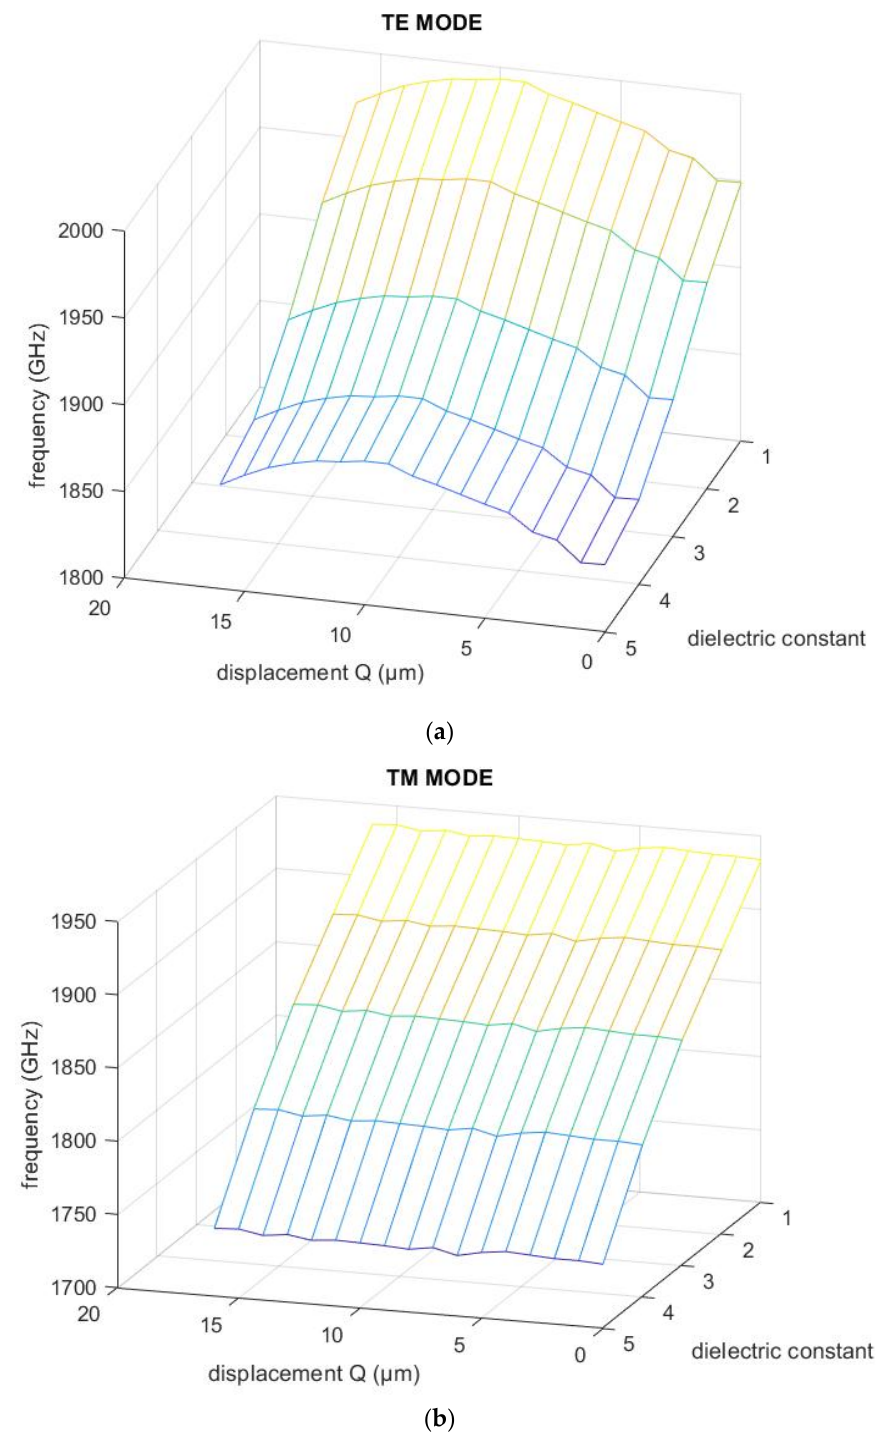
Figure 9. Resonance change as a function of permittivity value of an additional layer: ( a ) change in resonant frequency in TE mode; ( b ) change in resonant frequency in TM mode.